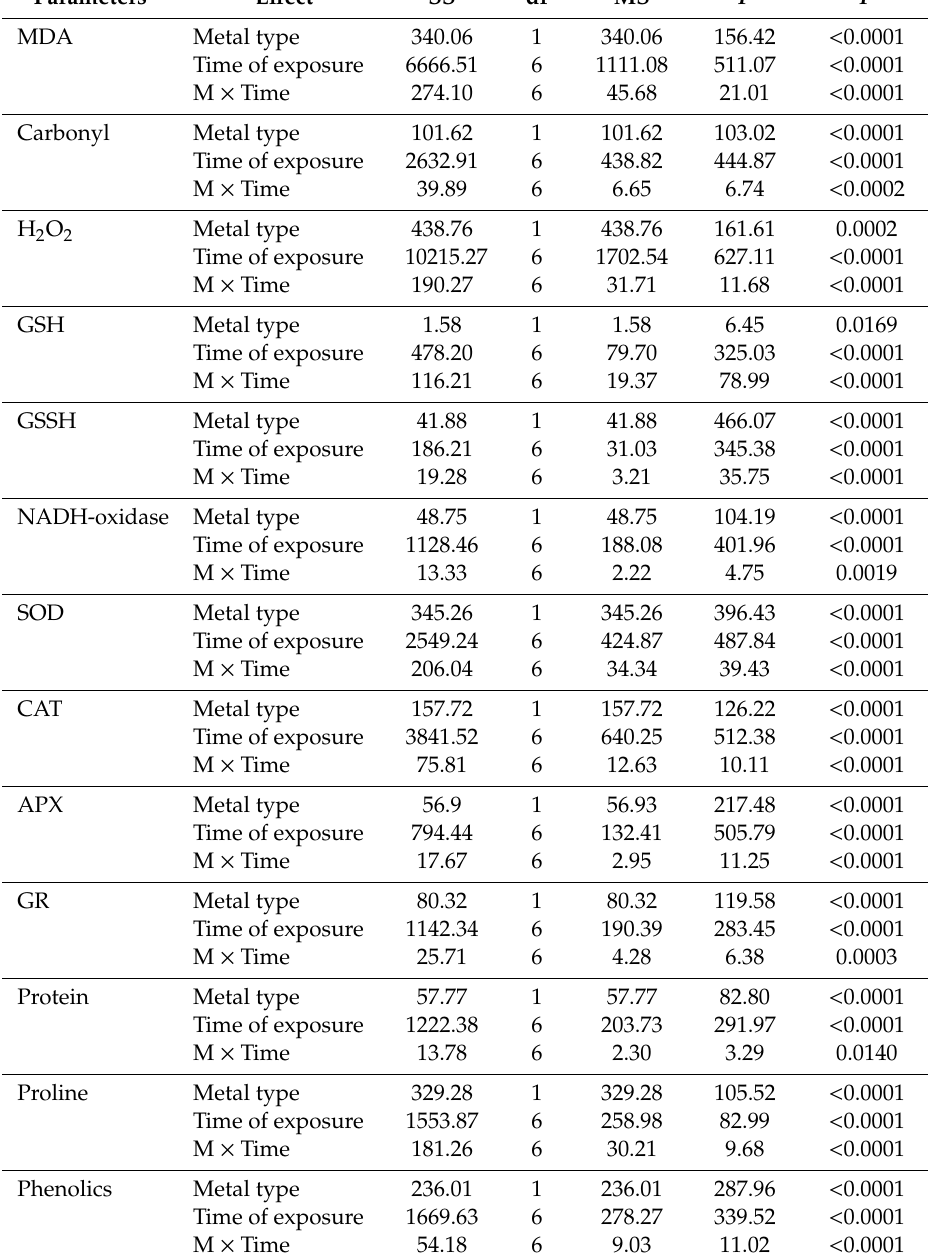
Table 1. Results of two-way analysis of variance in various parameters under treatments with heavy metals (Cd or Ni) at a di ff erent time of incubation (0, 12, 24, 36, 48, 60, and 72